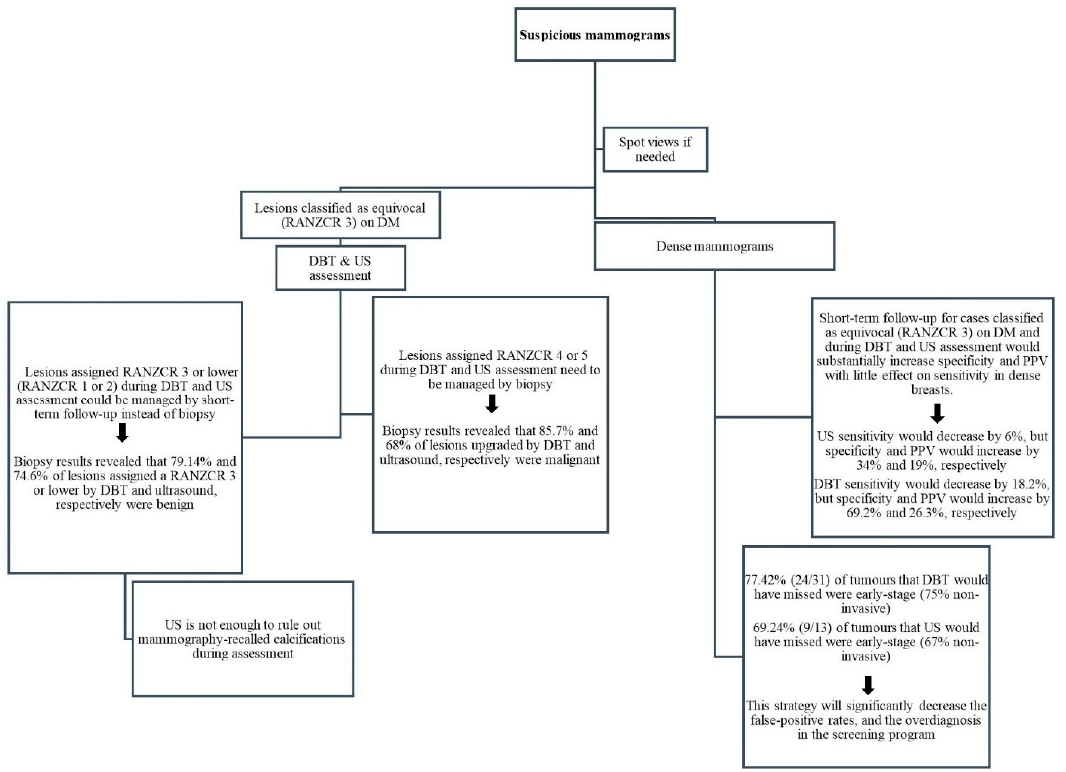
Figure 2. Proposed system architecture for optimising breast cancer detection during DBT and US assessment.